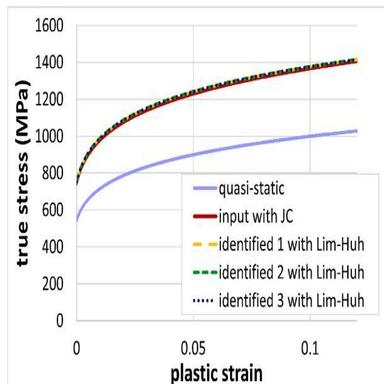
Comparison of stress-strain curves between the input with Johnson-Cook model and the identified using the VFM with Lim-Huh model at the strain rate of 200 s − 1 .